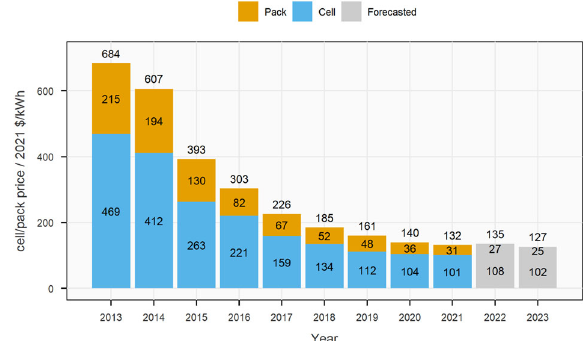
Fig.6|BatteryCell/Packpriceforecast. The fi gureshowstherealaveragedecline in the battery pack and cell prices for lithium-ion batteries from 2013 – 2021. Prices are split between the cell and pack components. The 2022 and 2023 prices are forecasted prices based on expected changes to critical battery raw materials. The forecasted projections are based on the state of the market in November 2021 197